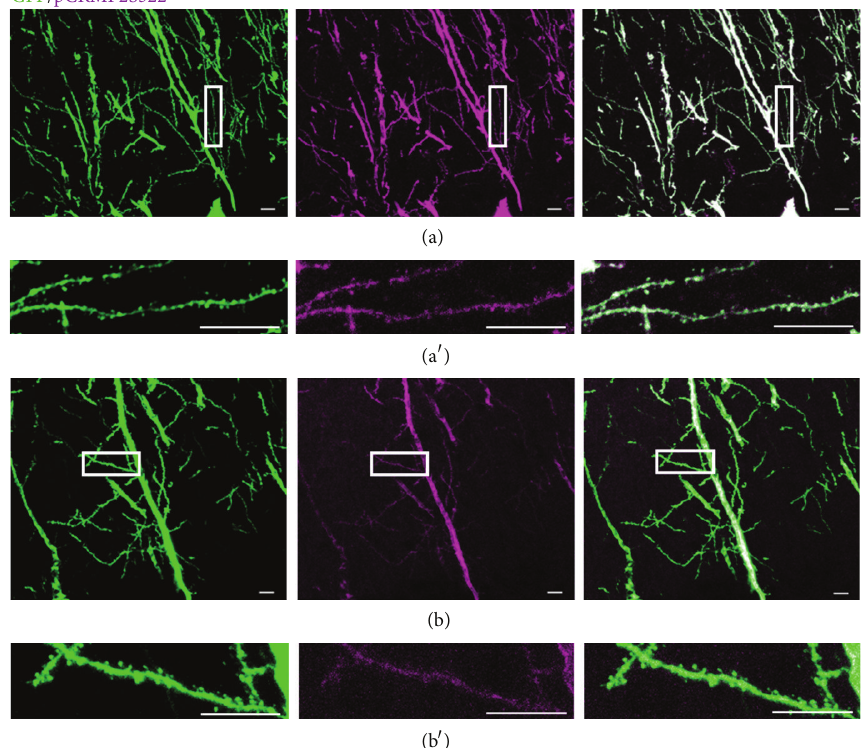
Figure 3: Localization of phospho-CRMP2 at dendritic spines of hippocampal CA1 pyramidal neurons. (a) Representative images of immunostaining of apical dendrites and their branches with phospho-CRMP2(S522) (pCRMP2S522) antibody in hippocampal CA1 pyramidal neurons from GFP-M mice. Magnified images of the areas indicated in (a) are shown in (a 󸀠 ). Scale bar, 10 𝜇 m. (b) Representative images of immunostaining of apical dendrites and their branches with pCRMP2S522 antibody of hippocampal CA1 pyramidal neurons in GFP-M, CRMP2 KI / KI mice. Magnified images of the areas indicated in (b) are shown in (b 󸀠 ). Scale bar, 10 𝜇